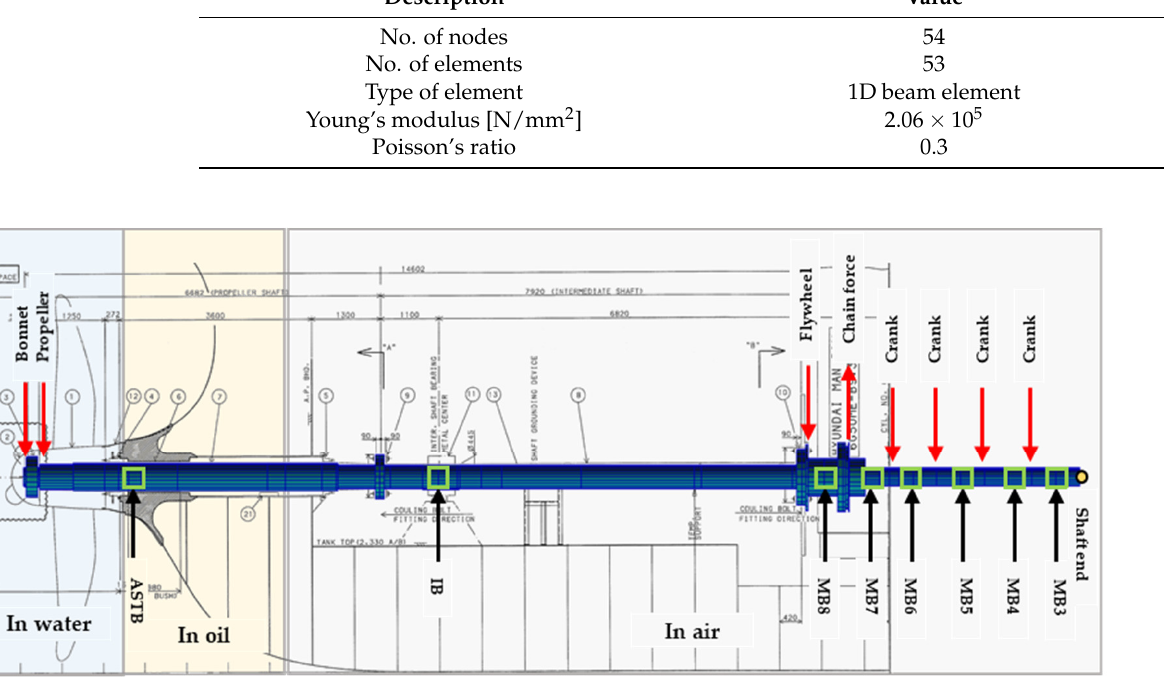
Table 9. Shaft FE model applied loads.